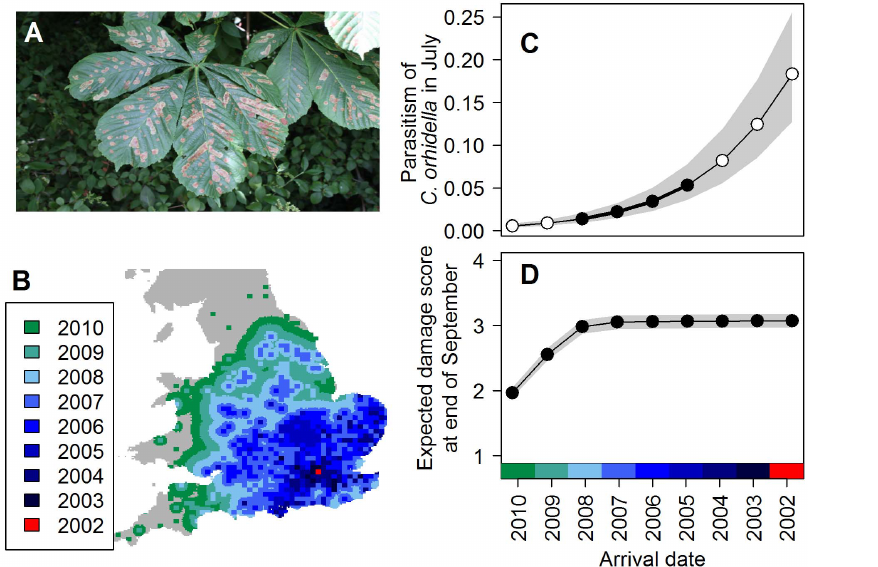
Figure 2. The spread of the leaf-mining moth and how the length of time it has been present in a location affects leaf damage and the level of attack by parasitoids. (A) The larvae of the leaf-mining moth Cameraria ohridella cause distinctive damage to horse-chestnut leaves. (B) The modeled distribution of the spread of C. ohridella produced by augmenting the observed distribution after 2006 with a demographic model of spread assuming two generations per year. (C) The effect of the length of time that C. ohridella has been present on levels of attack by parasitoids (‘parasitism’) as estimated from the data (black points) and extrapolated from the model (white points) with the inter-quartile range (grey). (D) The effect on leaf damage of the length of time that C. ohridella has been present, based on expected results from an ordinal regression, with inter- quartile range (grey).